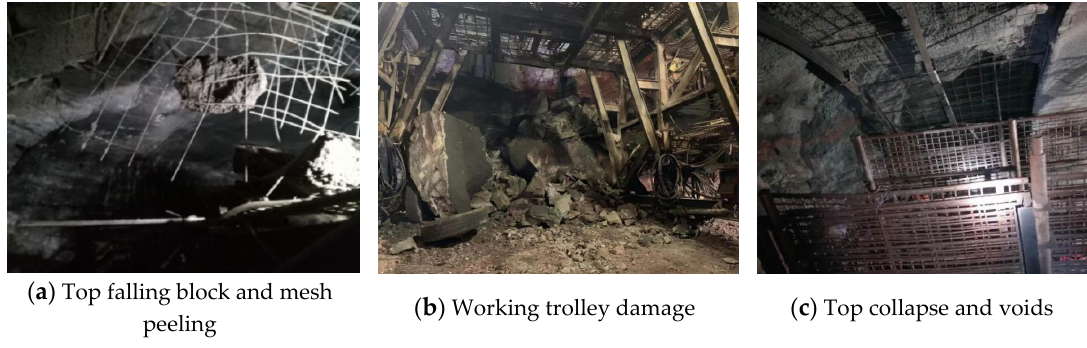
Figure 2. Photos of tunnel collapse.